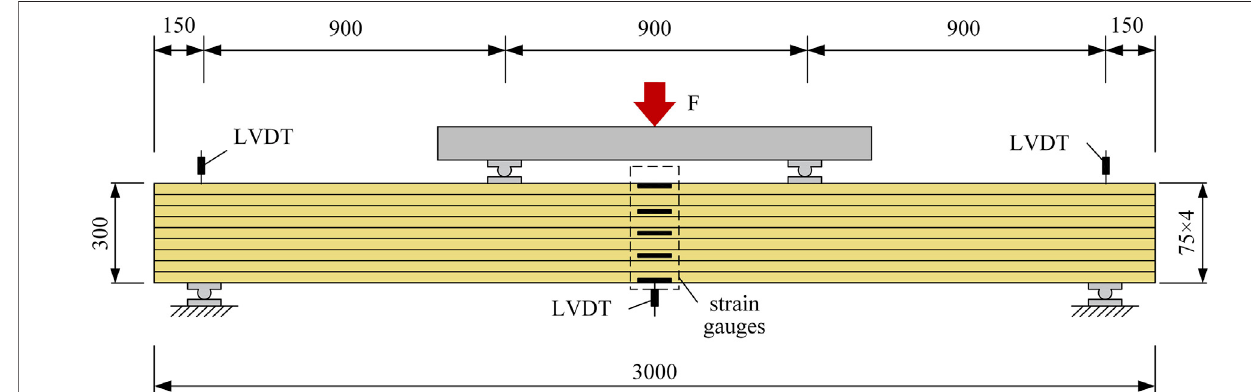
FIGURE 2 | Four-point bending test setup.